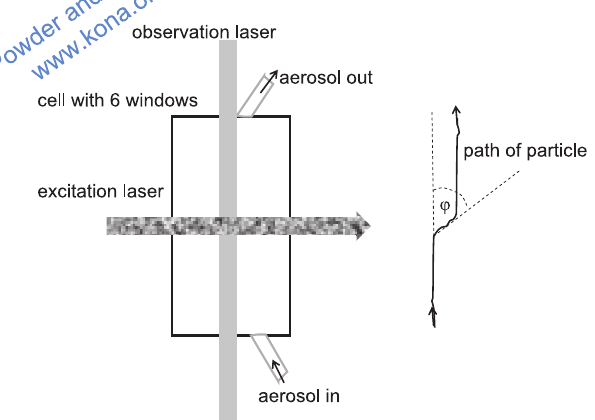
Fig. 14 Experimental determination of the photophoretic velocity: A continuous aerosol flow passes a small cell which is illuminated by a vertical laser beam. When illuminated by the horizontal laser beam, the particles move in the direction of the light. The motion of the particles is observed with a video camera. The path of the particles is shown on the right.